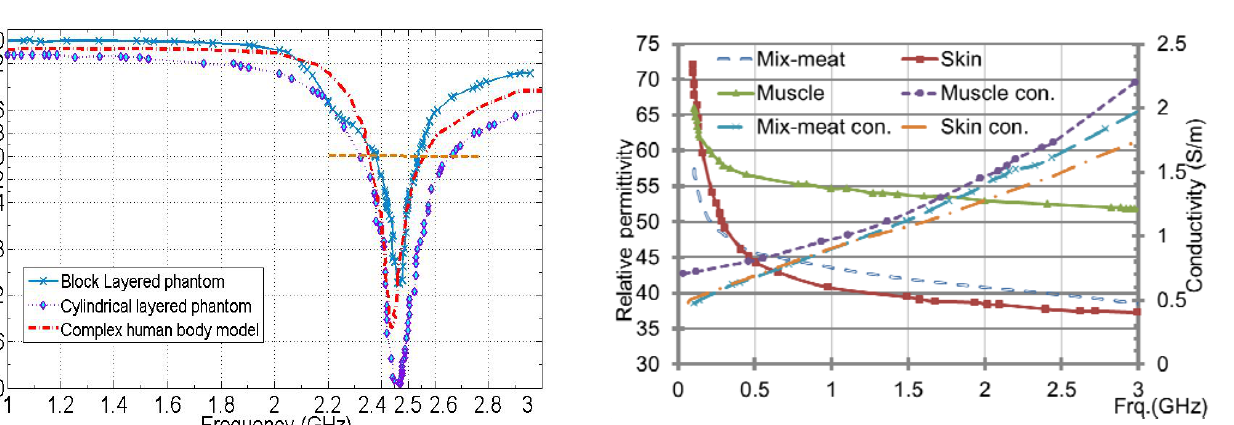
Figure 5: Calculated Reflection coefficient of Dual-slot PIFA: Layered Block and cylindrical phantoms versus Complex human body phantom.